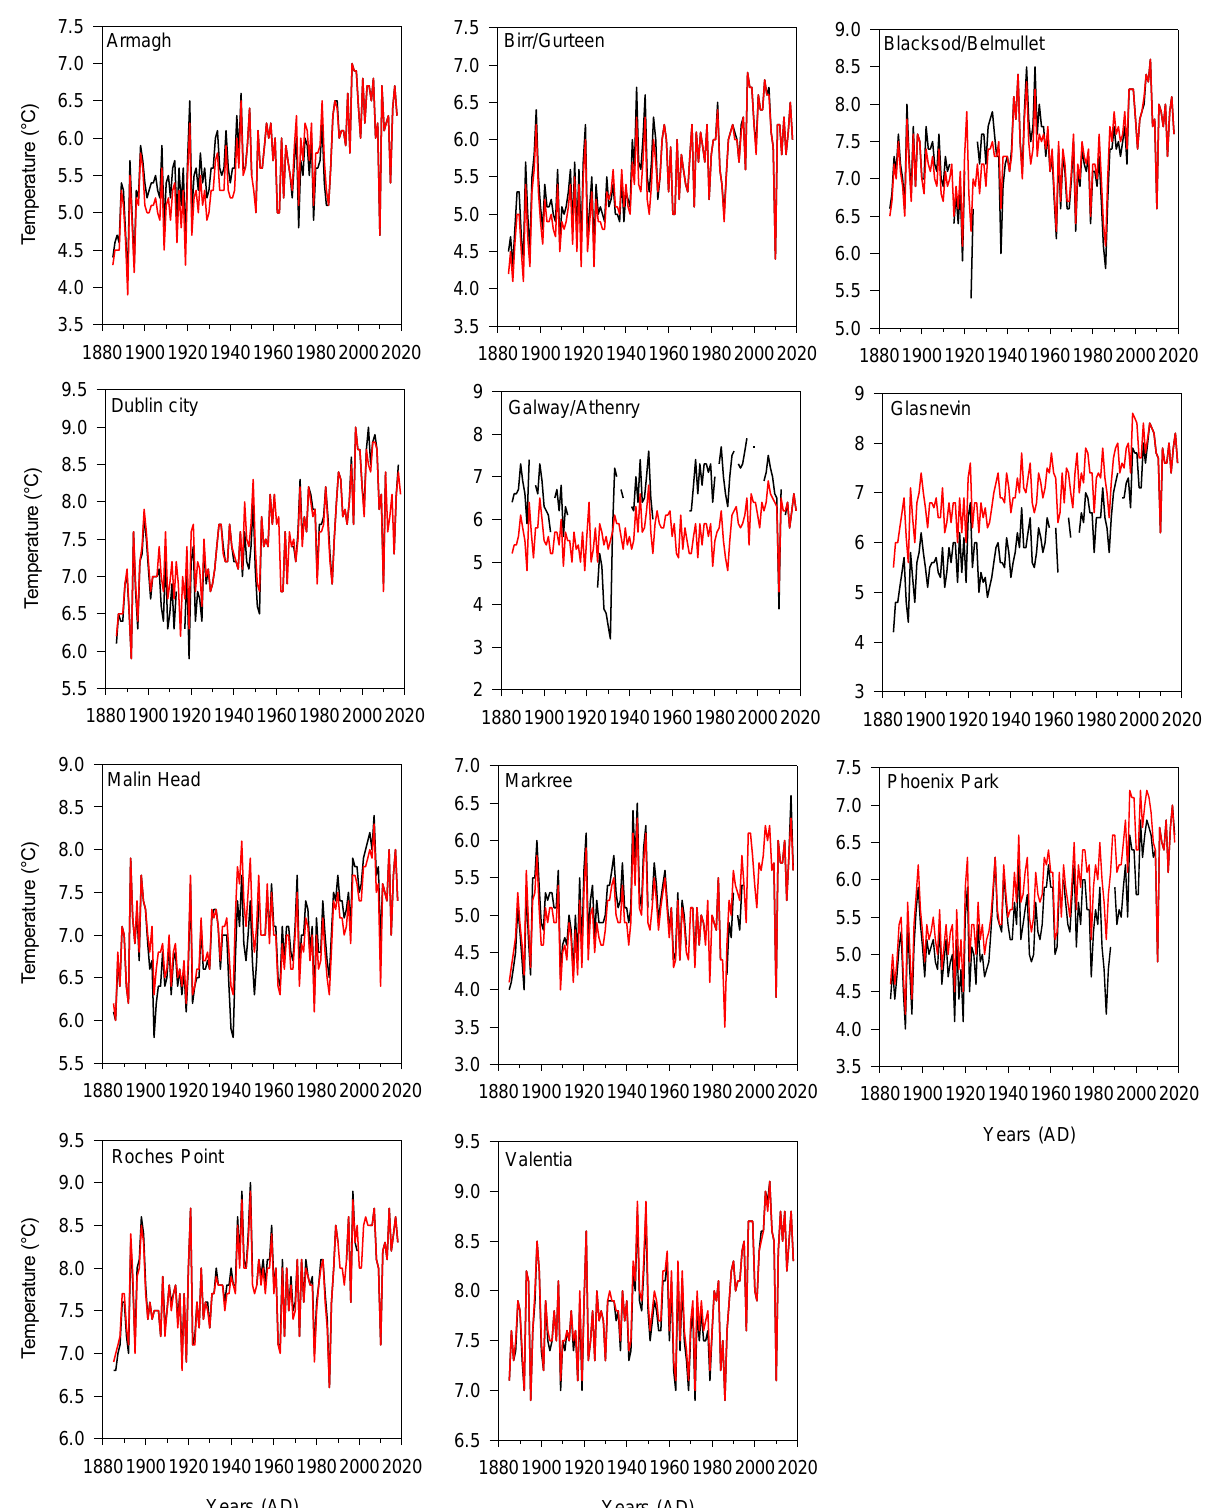
Figure 5. Quality-controlled (black) and homogenised (red) annual MIN series as part of regional networks in 1885 – 2018.